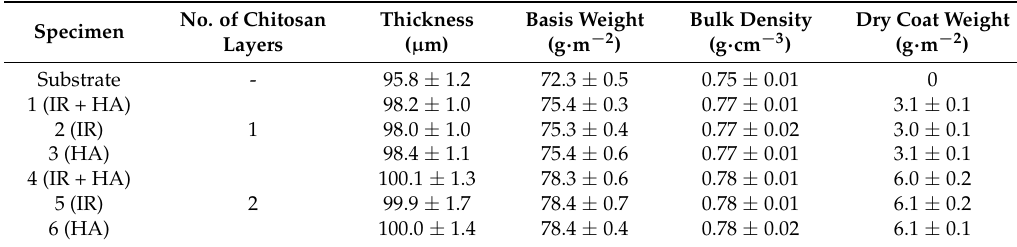
Table 4. Basic characterization: thicknesses, basis weight, bulk densities, dry coat weights and number of chitosan layers of substrate and coated samples from trials 1–6 ( n =